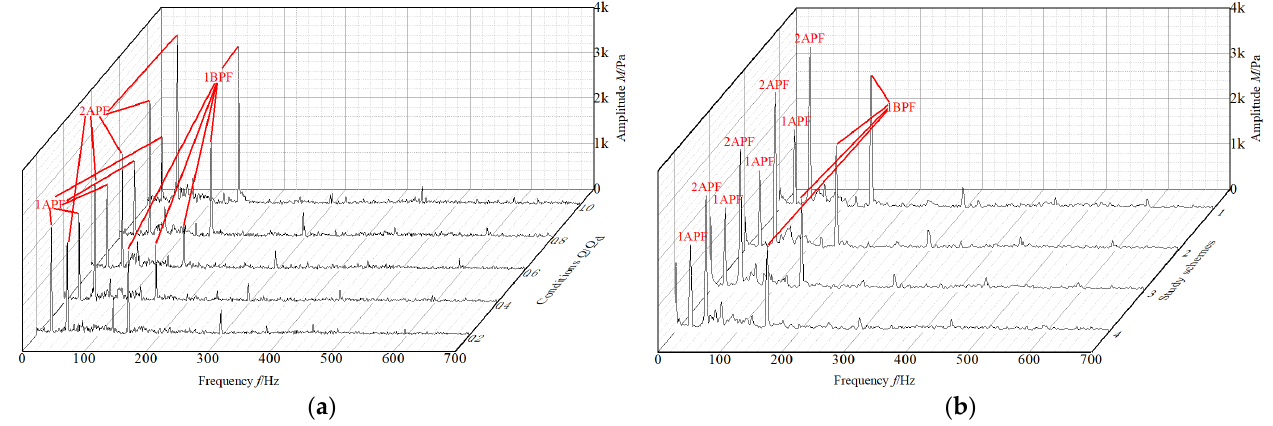
Figure 7. Frequency distribution at P1 under each ( a ) Steady conditions and ( b ) Transient conditions.